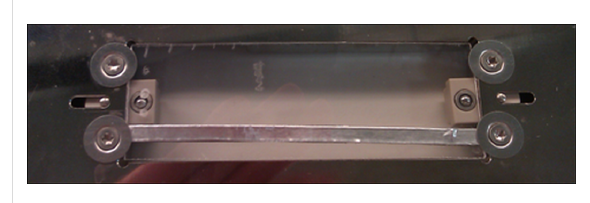
Figure 5: Photo of the aluminium strip on the back of the polystyrene